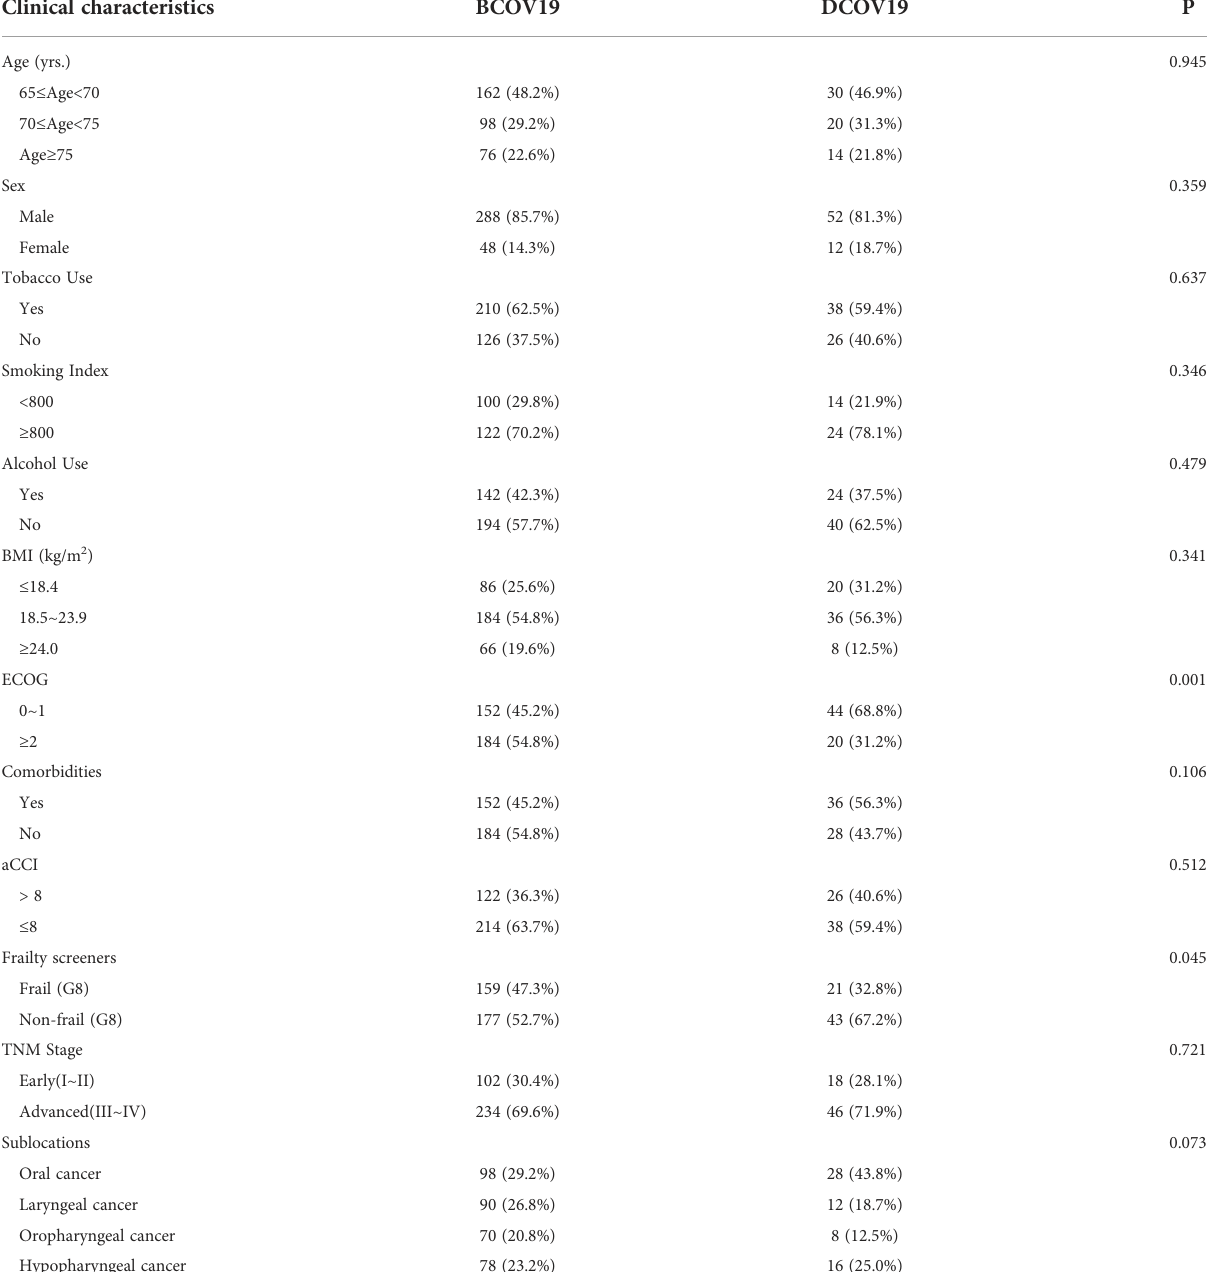
TABLE 1 Clinical characteristics of the 400 elderly patients with head and neck cancers. Clinical